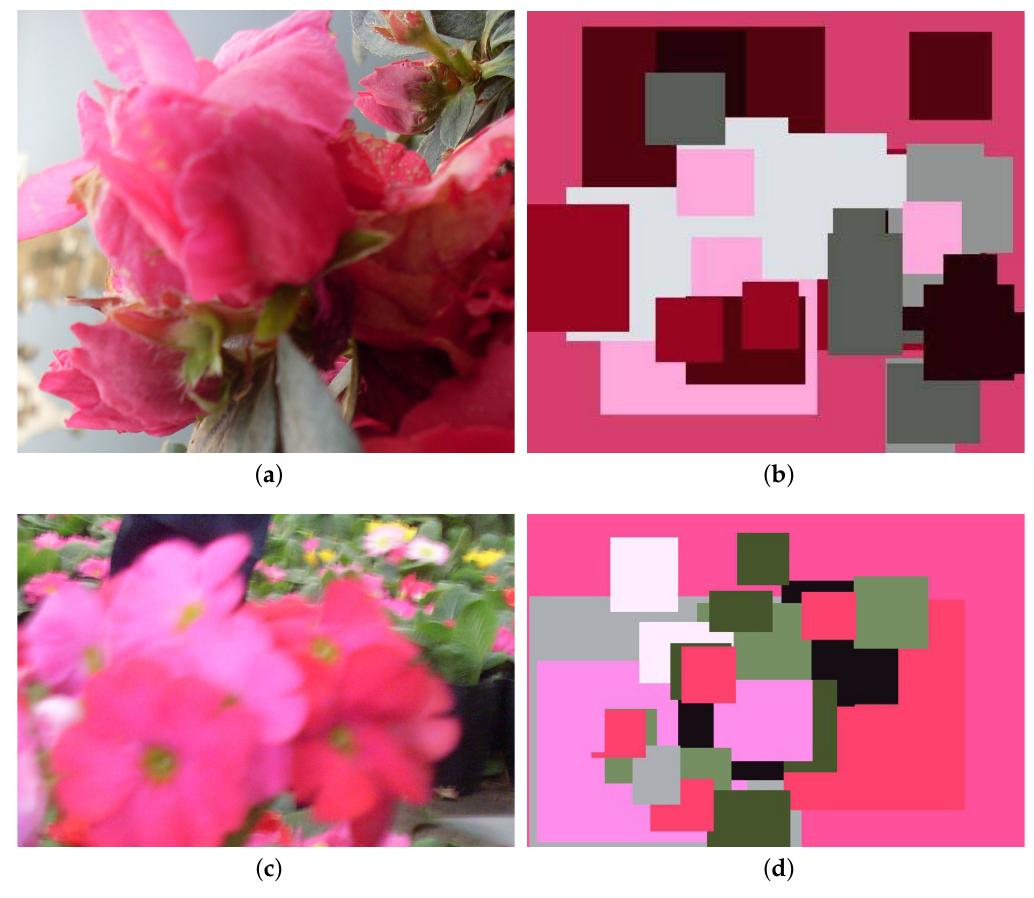
Figure 7. ( a , c ) An original picture; ( b , d ) Creation.